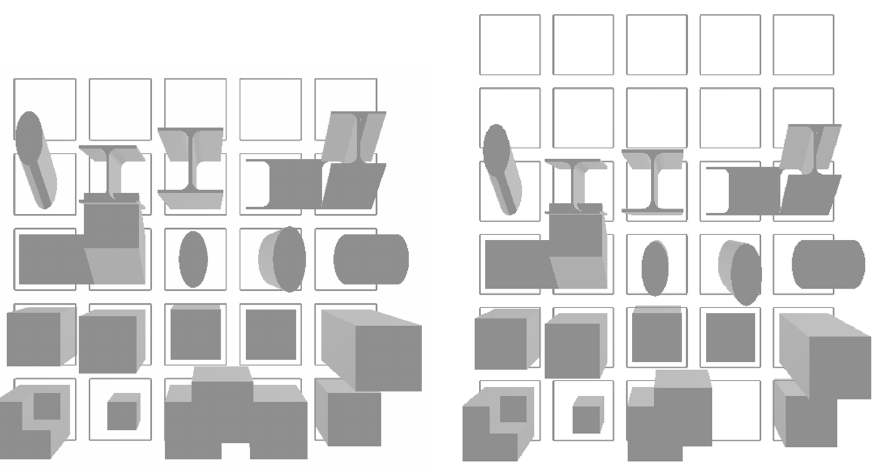
Figure 2. Case A: IFC geometries, both in IFC v.2x3 and v.4 converted to Generic city objects , visualized in